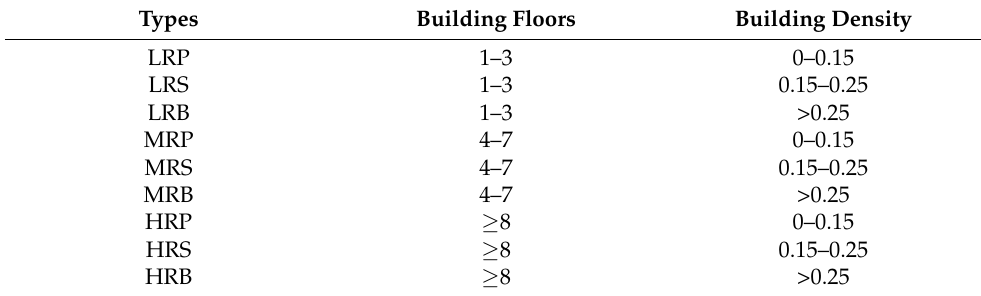
Table 1. Classification criteria of urban